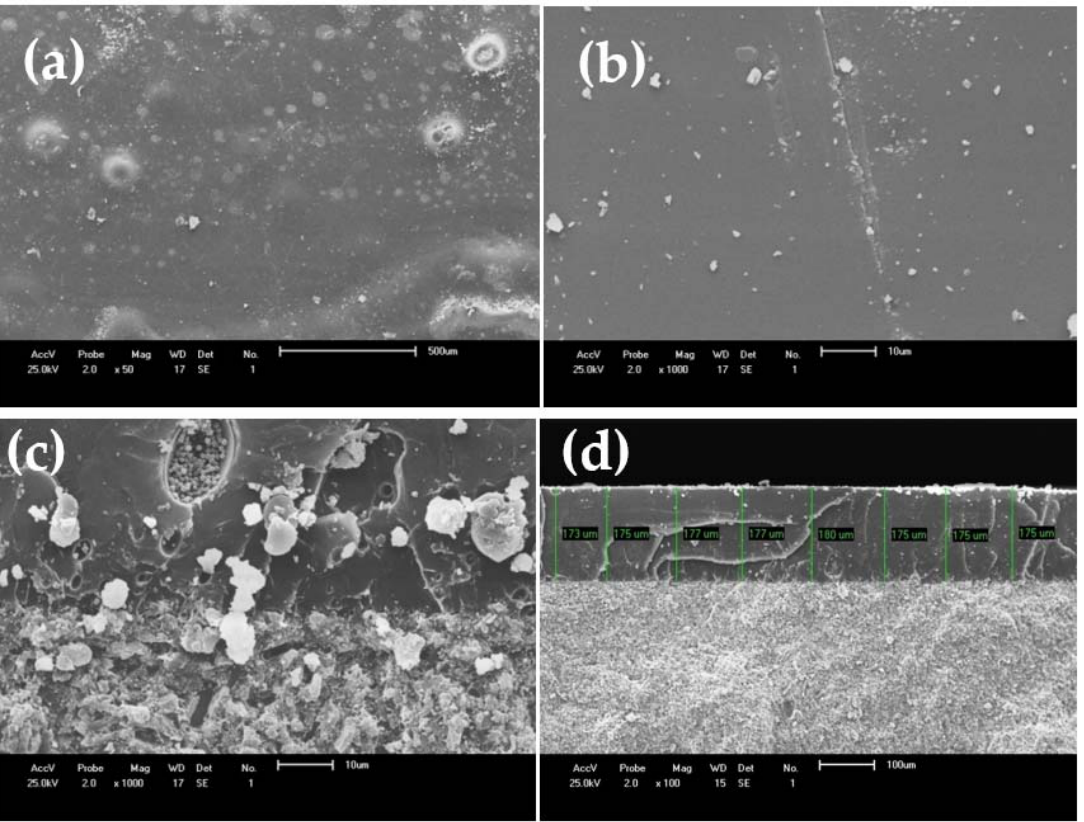
Figure 6. ( a , b ) SEM images from the surface, and ( c ) cross-section of Vitro-ceram infiltrated with PMMA for 6 h. ( d ) Sample cross-section image at lower magnification of ×100 and infiltration for 12 h. Table 3. Infiltration time, density, porosity and water absorption of sintered and infiltrated alu- mina preforms.